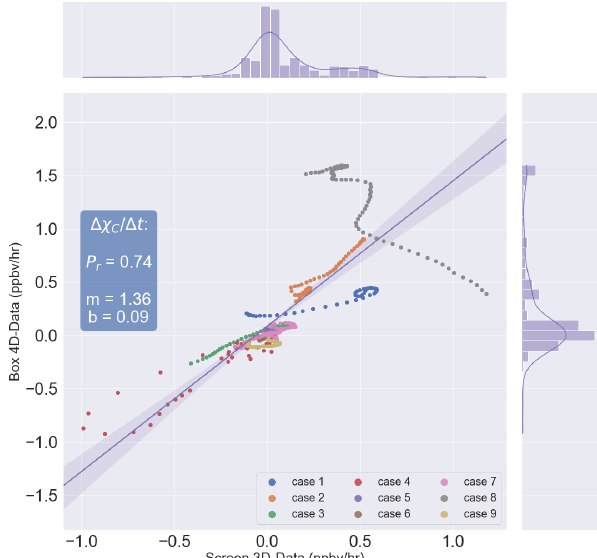
Figure 6. This three-panel graph demonstrates the correlation be- tween estimates of ∂χ C /∂t by analyzing 4D (box) and 3D (con- secutive screens) data sets. The vertical side plot shows the range and distribution of ∂χ C /∂t estimates for the period of nine stud- ied flights by 4D analysis, the horizontal side plot shows the same for 3D analysis. The main panel demonstrates the correlation be- tween the two methods of estimation. Pearson correlation coef- ficient ( P r = 0 . 74) shows the strength of this relation. The least- squares fit line has slope m = 1 . 36 and intercept b = 0 . 09. Note that case 8 estimates are in low correlation due to relatively high up- wind emissions during the time of that particular flight case (28 Au- gust), rendering the 3D estimates less representative of the 4D es- timates. Excluding case 8 from this analysis, results in P r = 0 . 88, ∗ m = 1 . 07 and b = 0 . 03. E tr can be estimated from multiple con- C , S secutive 2D screens, by assuming 3D estimations of ∂χ C /∂t as rep- resentative of the rate of change in species mass within the flux box. The same can also be estimated from downwind vertical profiling of tracer concentrations over the sampling